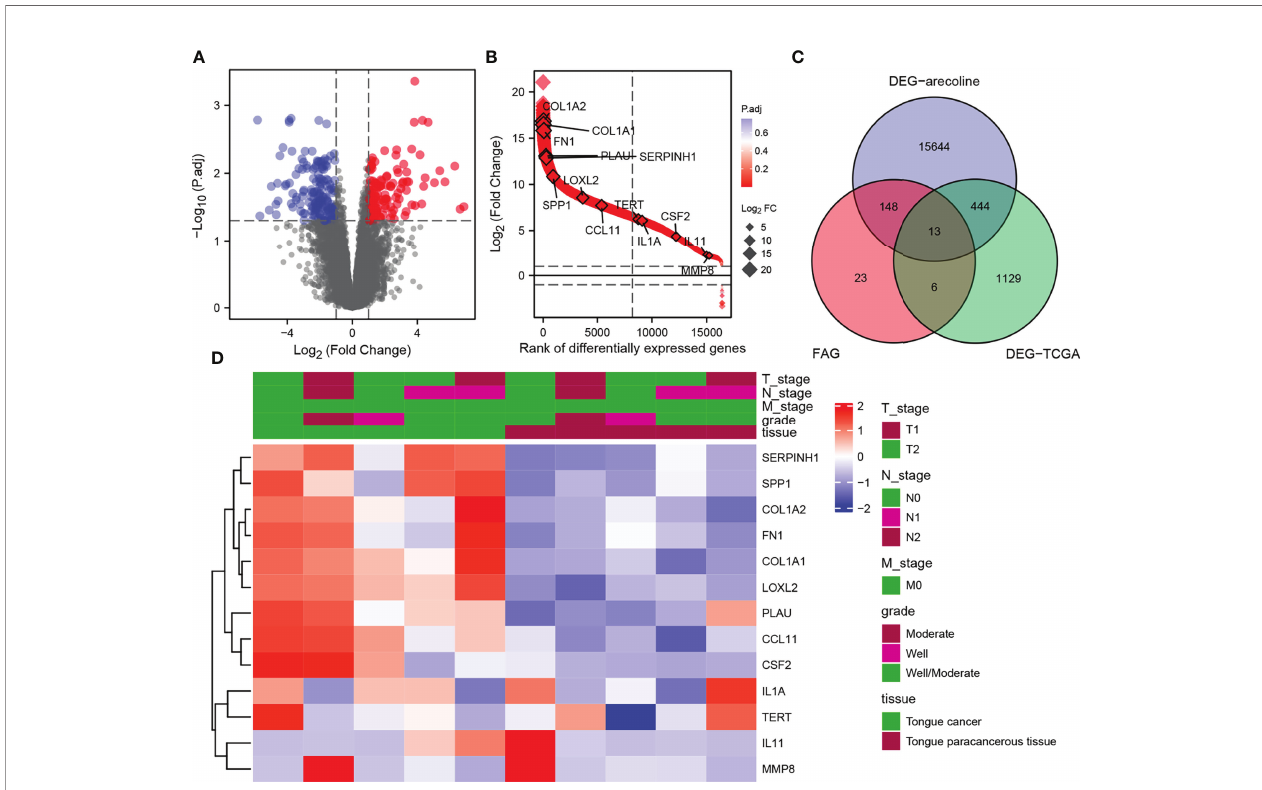
FIGURE 2 | Identi fi cation of DEGs in arecoline-related OSCC. (A) Volcano plot shows all DEGs screened from the GEO database. (B) The expression levels of the thirteen DEGs screened. (C) Venn diagram demonstrates the intersections of genes between GEO, TCGA, and FAG databases. (D) Heatmap shows the association of the selected DEGs with the TNM stage and pathological stage. DEGs, differentially expressed genes; OSCC, oral squamous cell carcinoma; GEO, Gene Expression Omnibus; TNM, tumor node